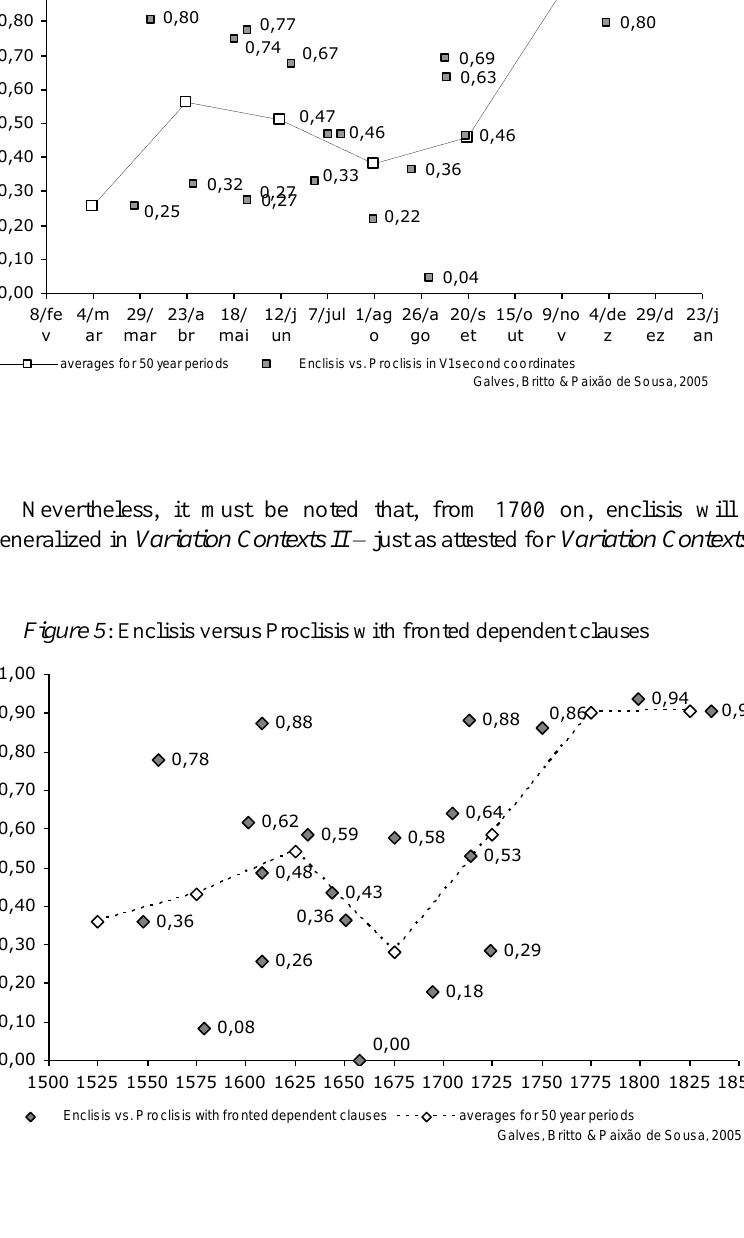
Figure 4 : Enclisis versus Proclisis in V1 second coordinates